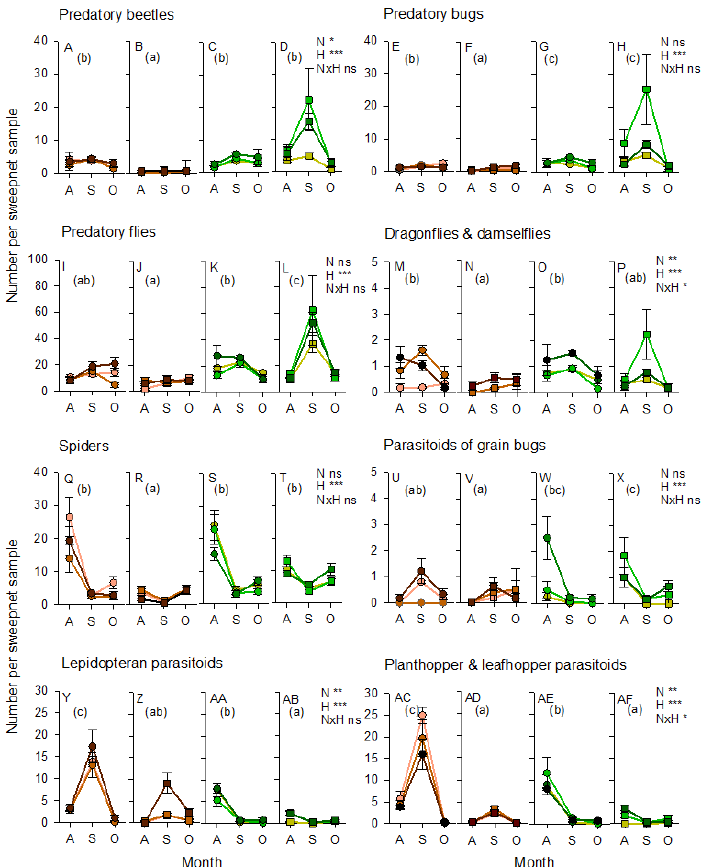
Figure 7. Relative abundance of the principal natural enemies of rice herbivores from sweepnet sampling of rice plots during August (A), September (S), and October (O) of 2013. Samples from clear bunds and adjacent rice are indicated by brown lines and symbols with samples from mung bean bunds and adjacent rice indicated by green lines and symbols. The abundance of predatory beetles ( A – D ), predatory bugs ( E – H ), predatory flies ( I – L ), dragonflies and damselflies ( M – P ), spiders ( Q – T ), egg parasitoids of grain bugs ( U – X ), larval and egg parasitoids of lepidopteran herbivores ( Y – AB ), and egg and nymph parasitoids of planthoppers and leafhoppers ( AC – AF ) are indicated. Plots were planted with IR64 and received one of three nitrogen-fertilizer treatments (indicated by color intensity of points, N1 = light, N2 = medium, N3 = dark). Samples were collected from the rice crop (circles, A, C, E, G, I, K, M, O, Q, S, U, W, Y, AA, AC, AE) and from bund vegetation (square symbols, B, D, F, H, J, L, N, P, R, T, V, X, Z, AB, AD, AF). Standard errors are indicated ( n = 8). GLM results for the effects of nitrogen (N), habitat type (H) and their interactions (N × H) are indicated for each predator/parasitoid group; ns = p > 0.05, * = p < 0.05, ** = p < 0.01, *** = p < 0.001. Lowercase letters indicate homogenous habitat groups.